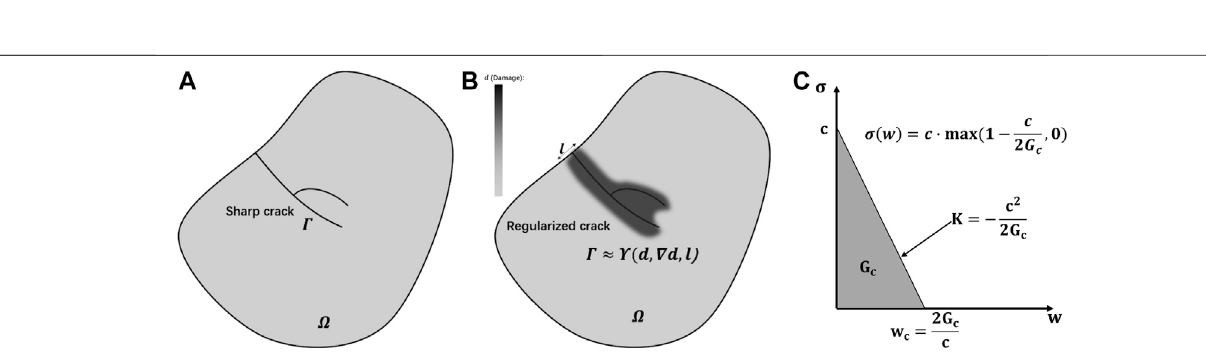
FIGURE4| Micro-UDmodeofSiC f /SiCcomposite: (A) random fi berdistributioninRVEmodelwitha fi bervolumefractionof70%; (B) fi bersset; (C) matrixset;and (D) cohesive interfaces set with 0.001 μ m thickness.